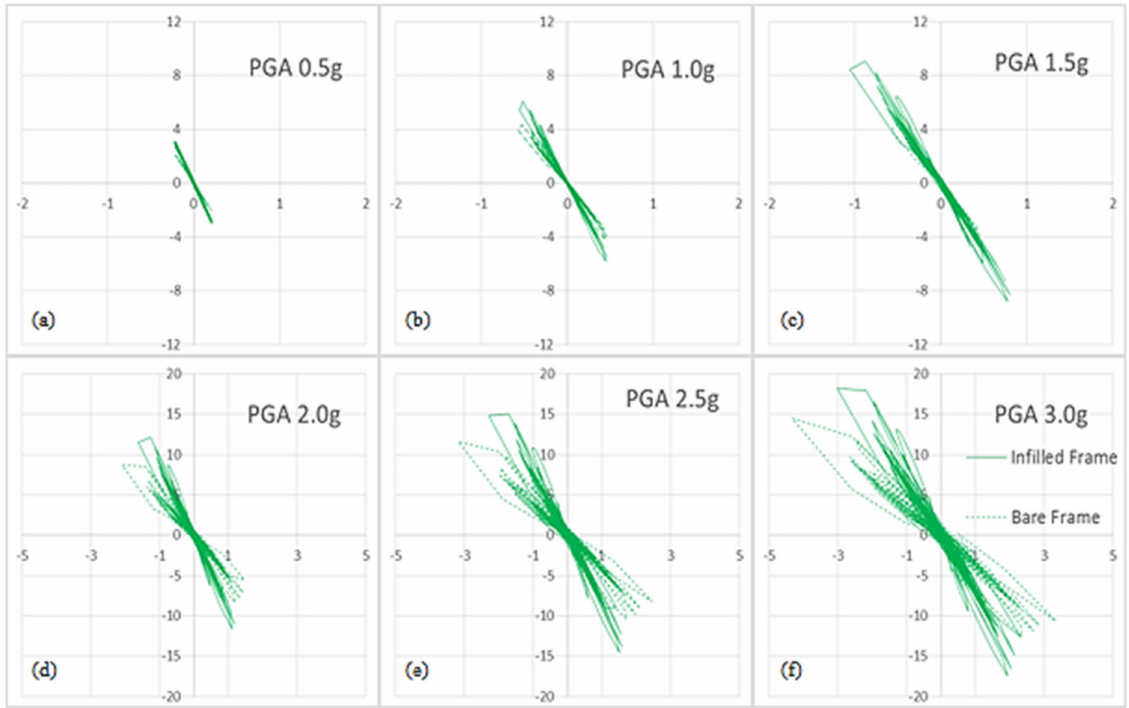
Figure 20. Comparison of base shear and top lateral displacements of AEM models for H-building structure (IFM and Bare Frame building structure) at PGA: ( a ) 0.5 g; ( b ) 1.0 g; ( c ) 1.5 g; ( d ) 2.0 g; ( e ) 2.5 g; ( f ) 3.0